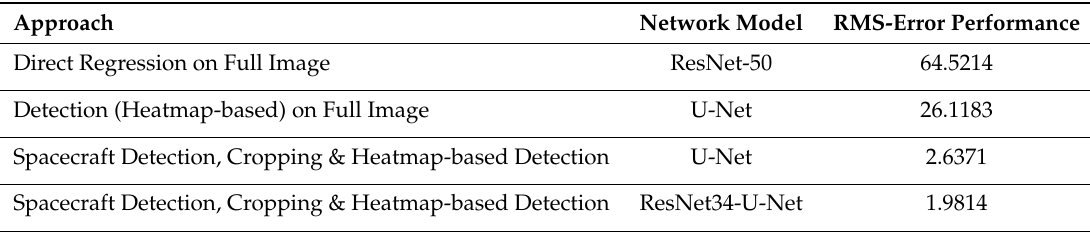
Table 5. Summary of the Performance of Network